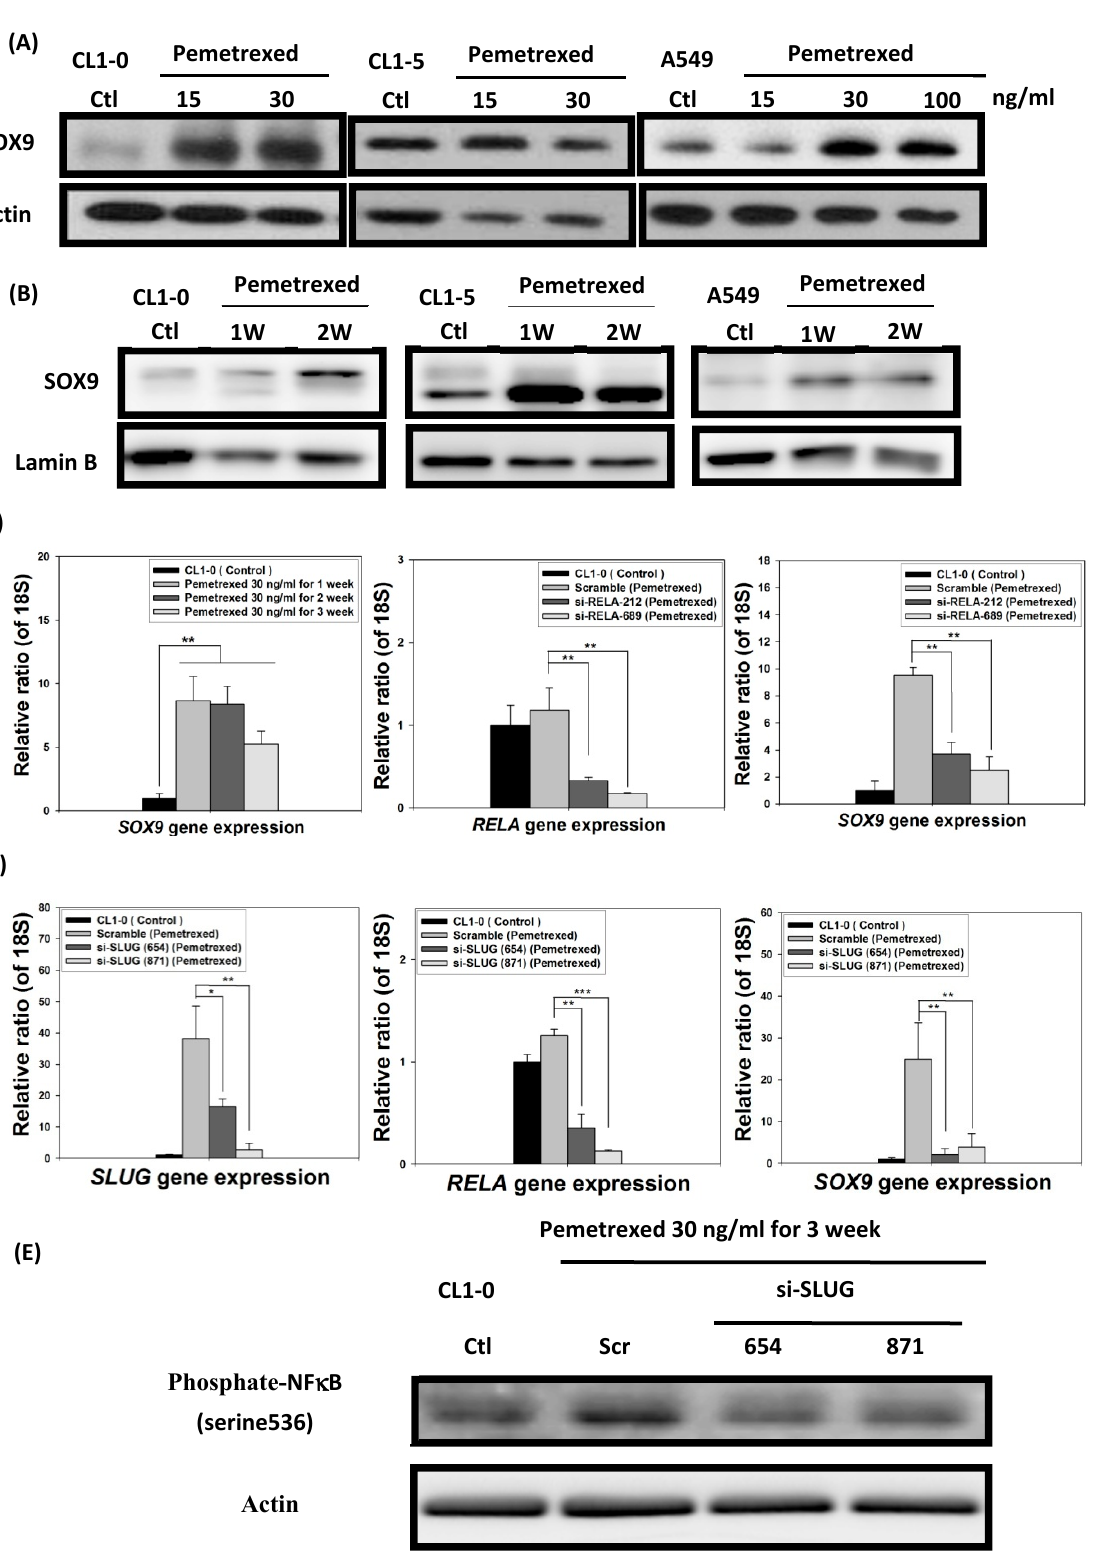
Figure 6. Folate antagonist unilaterally triggers the overexpression of Sox9 transcription factors in NSCLC cells. The expression and nuclear translocation of Sox9 were analyzed through Western blotting and RT-qPCR. The ( A ) total protein expression and ( B ) nuclear translocation of Sox9 were determined through Western blotting. ( C ) NF- κ B (RELA) knockdown by shRNA (si-RELA-212 and si-RELA-689) reduced Sox9 gene expression. ( D ) SLUG knockdown by shRNA (si-SLUG-654 and si-SLUG-871) also reduced NF- κ B (RELA) and Sox9 gene expressions. ( E ) SLUG knockdown abolished NF- κ B phosphorylation, as indicated by Western blotting, in CL1-0 cells. * p < 0.05; ** p < 0.01; *** p < 0.001.